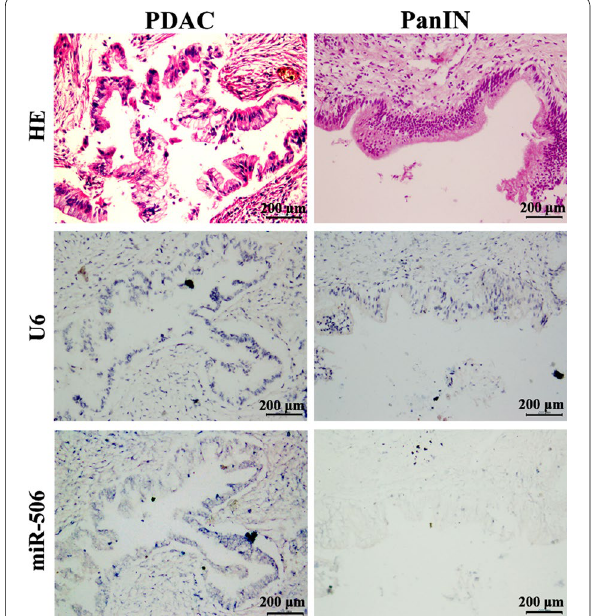
Fig. 2 The expression of miR‑506 in one PDAC and matched low‑ grade pancreatic intraepithelial neoplasia (PanIN). miR‑506 expression is obviously higher in PDAC than in the matched low‑grade PanIN